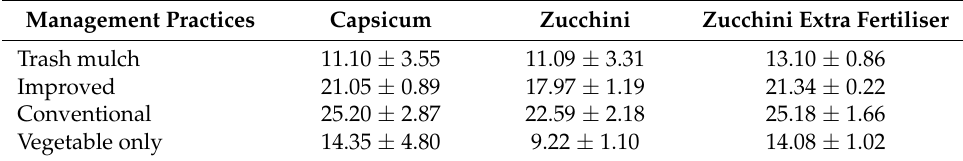
Figure 2. Impact of management systems on vegetable yield (t/ha) (mean with standard deviation). Table 2. Impact of management practices on vegetable yield (mean ± standard deviation).